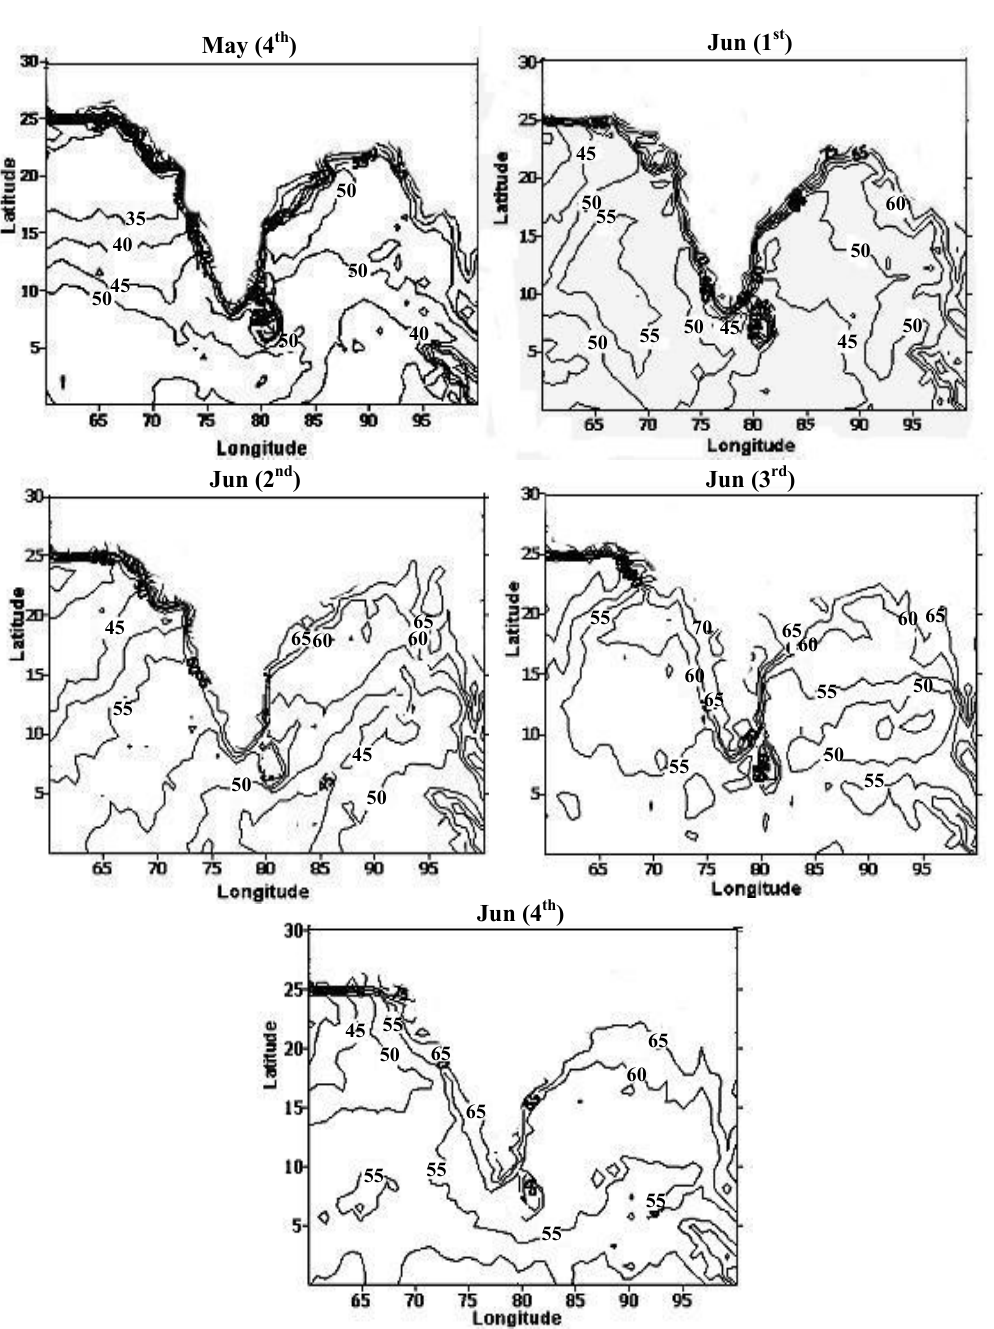
Fig. 1. Weekly variations of TPW (kg/m 2 ) prior and after onset of monsoon during 1997 (June 2nd week figure corresponds to the monsoon onset week). Table 1. Monsoon onset day during 1988 to 1998 (from Indian Meteorological Department,